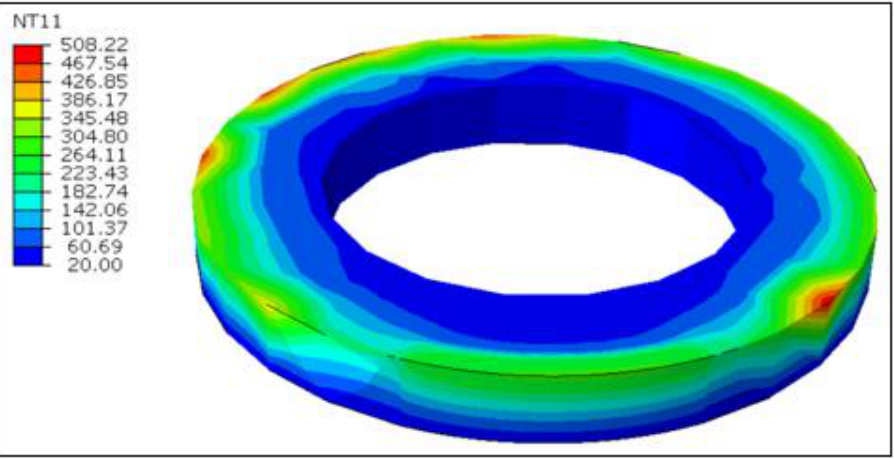
Figure 13. Steady-state tool surface temperature at V = 100 m/min for the rotary tool (°C).